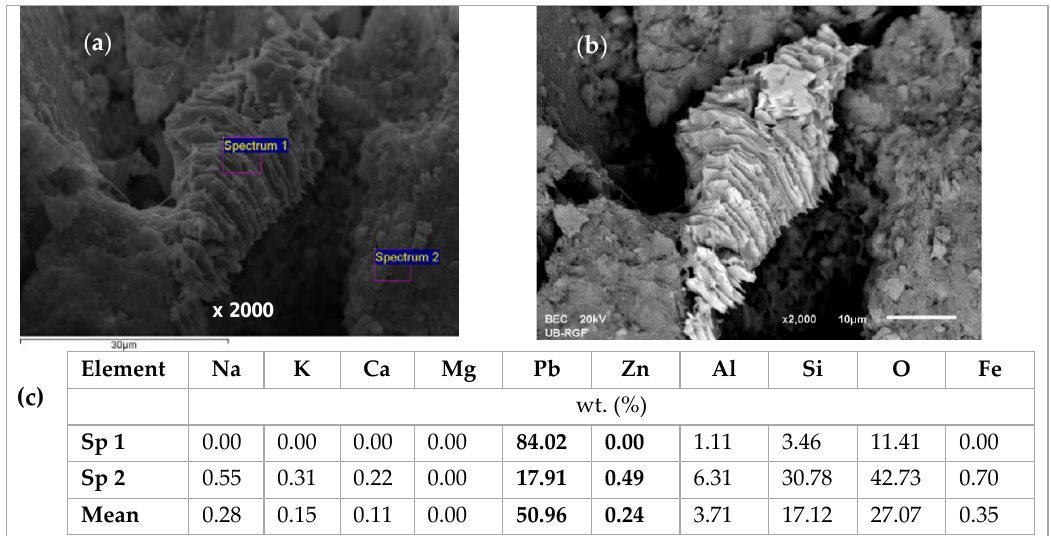
Figure 15. SEM images of white crystals for the (Pb + Zn) system and Pb/Zn = 1.07: ( a ) SE image x 5000 with two spectrums (Sp); ( b ) BSE image x 5000; ( c ) EDS analysis results.